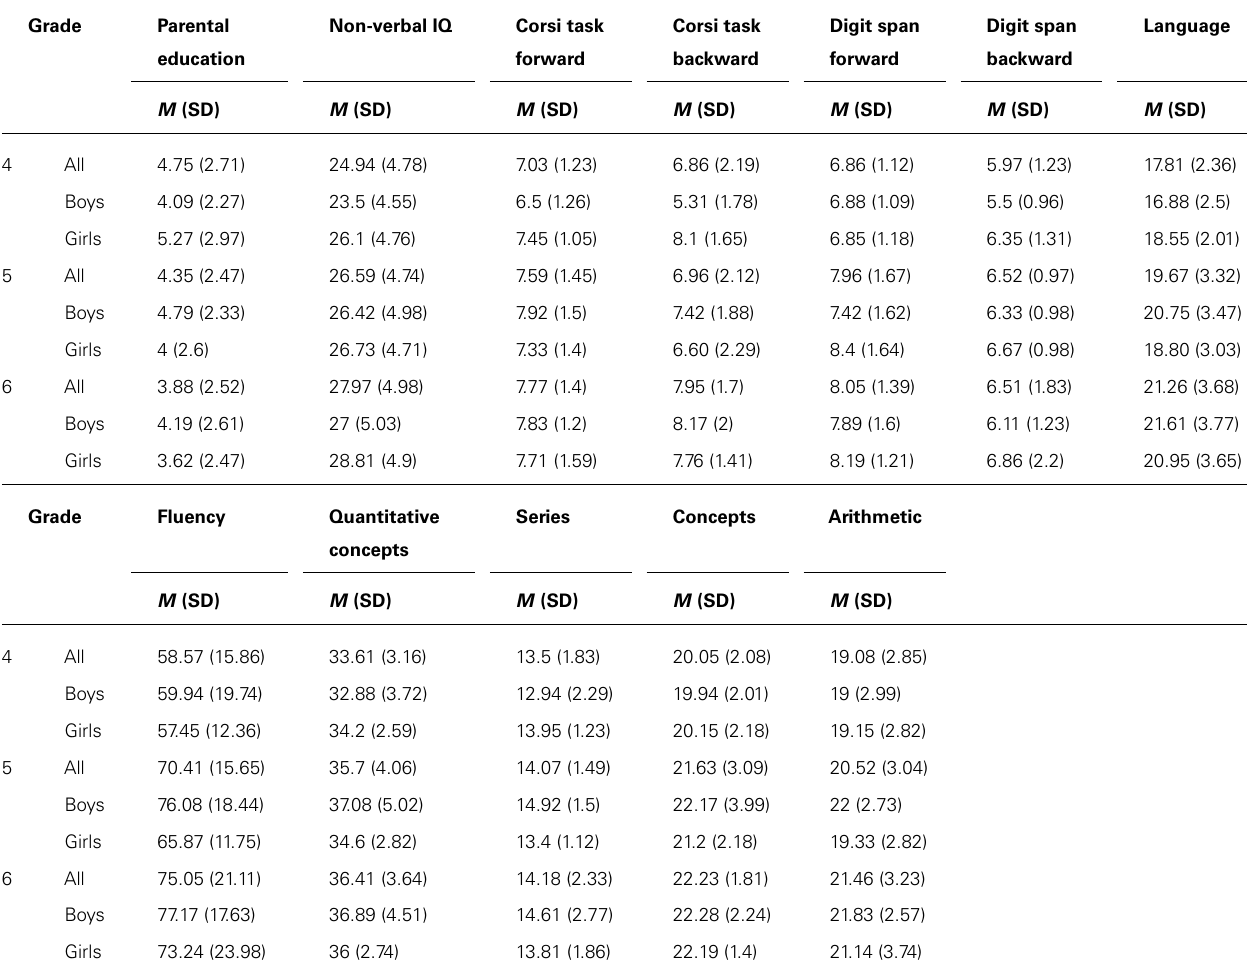
Table 2 | Mean total scores by grade and gender for all